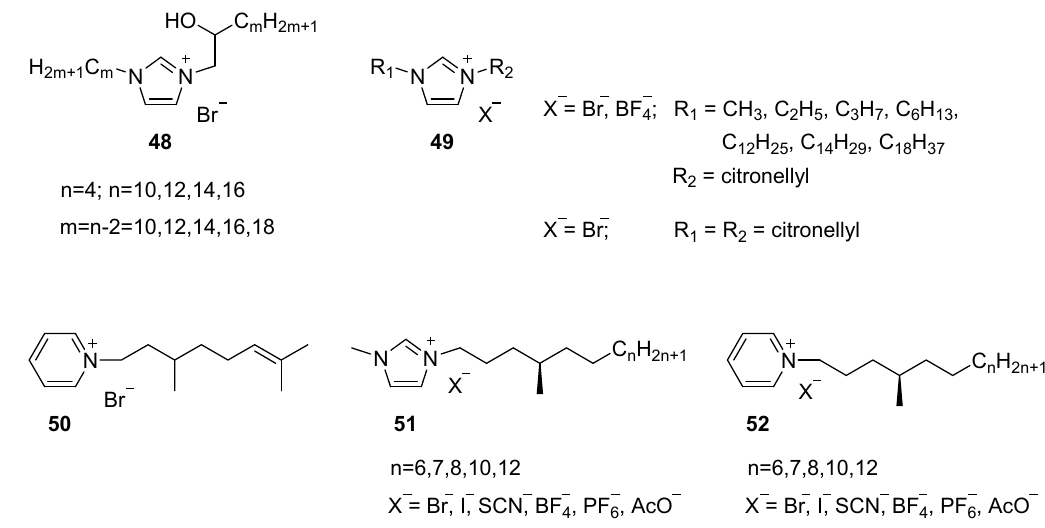
Figure 11. Substituents at the heteroatoms of imidazolium ( 48 , 49 , 51 ) and pyridinium ( 50 , 52 ) ILCs.